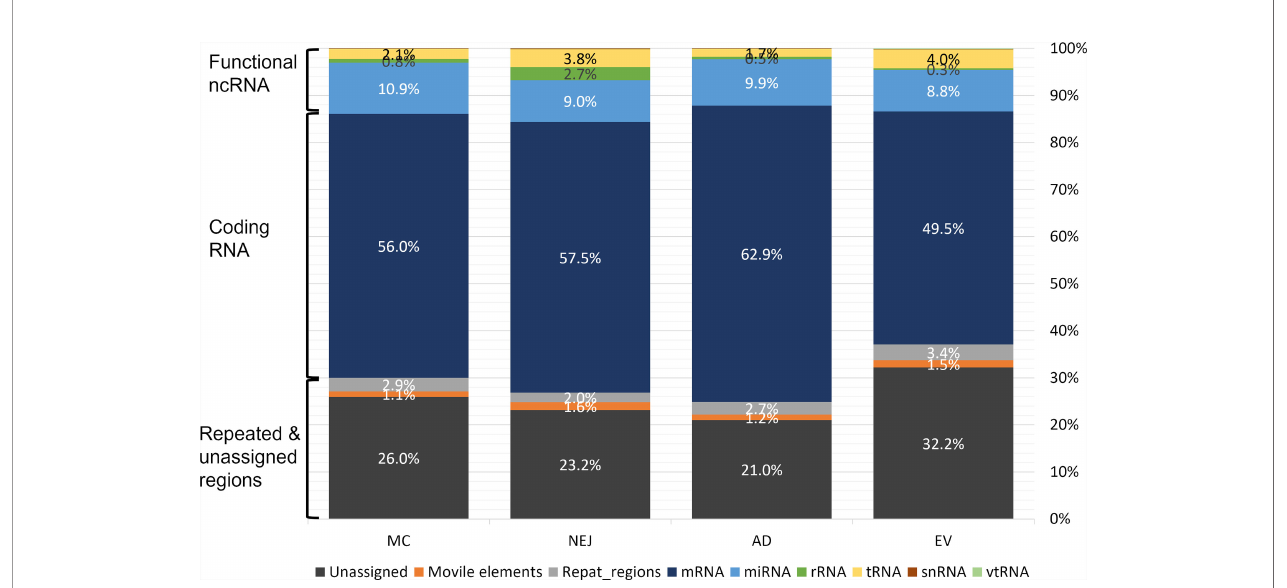
FIGURE 1 | Mapping of small RNA sequences from different stages of Fasciola hepatica to the genome. Samples were obtained from metacercaria (MC), newly excysted juvenile (NEJ) adult worms (AD), and adult-released extracellular vesicles (EVs). Mapping reads were classi fi ed in three main categories: functional non- coding (nc)RNA (rRNA, tRNA, small nuclear (sn)RNA, vault (vt)RNA and miRNA), coding RNAs (mRNA) and those associated to repeat and unassigned regions (mobile elements (e.g., transposons), regions with repeated sequences or regions that remain